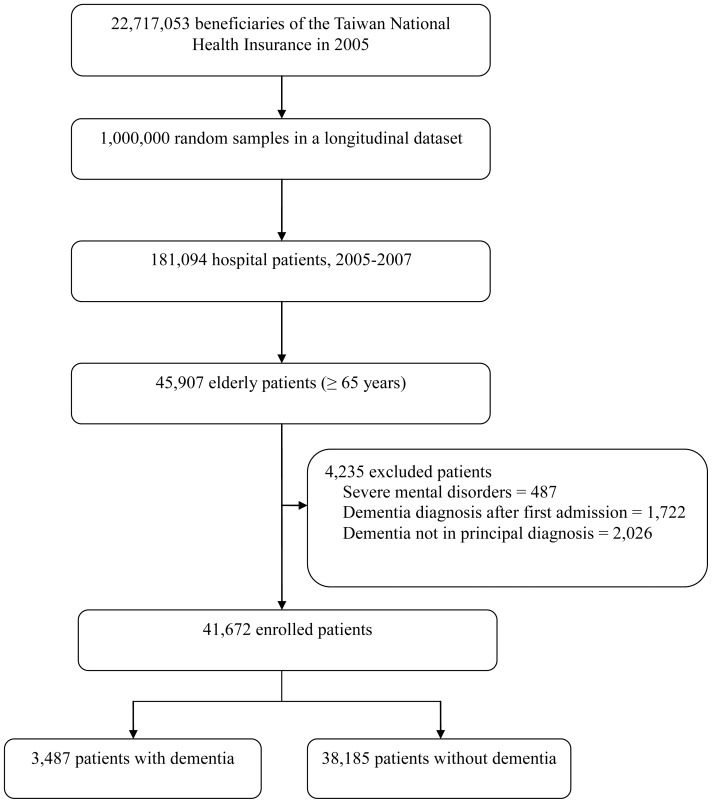
Study flow diagram.